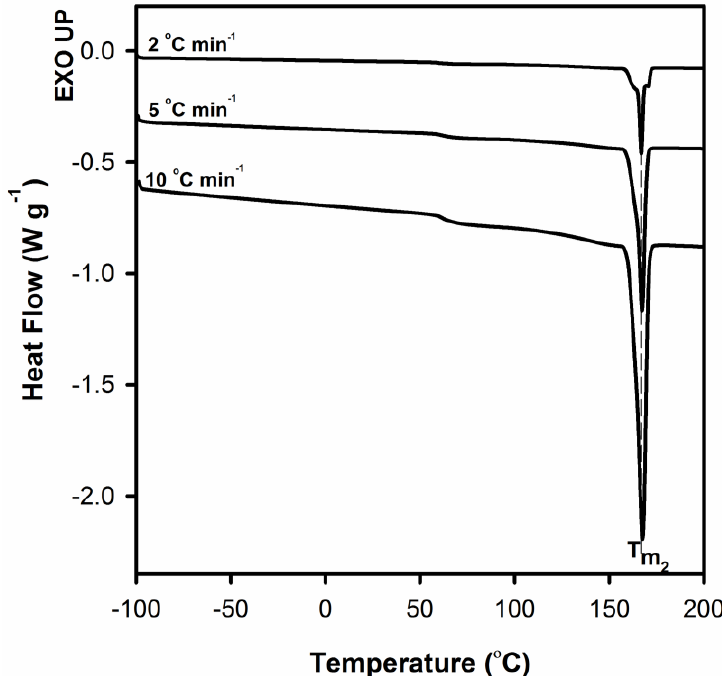
Figure 11. DSC melting thermograms of neat PLA after annealing at 155 °C for 10 min at different scan rates. Thermograms have been shifted along the vertical axis for better visualization.